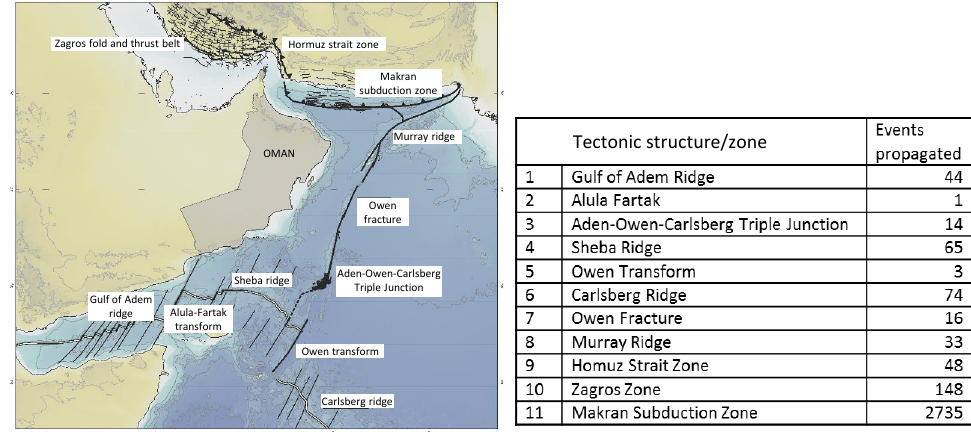
Figure 3. Main seismic areas surrounding the study area and number of events propagated for each